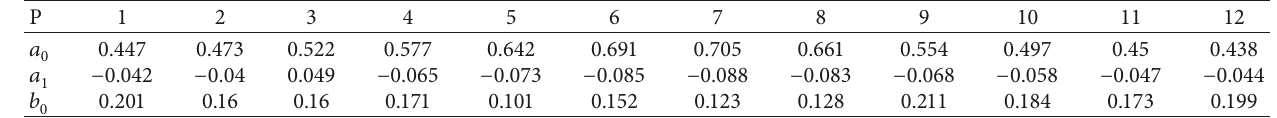
Table 1: Simulation parameters of net surface longwave radiation.